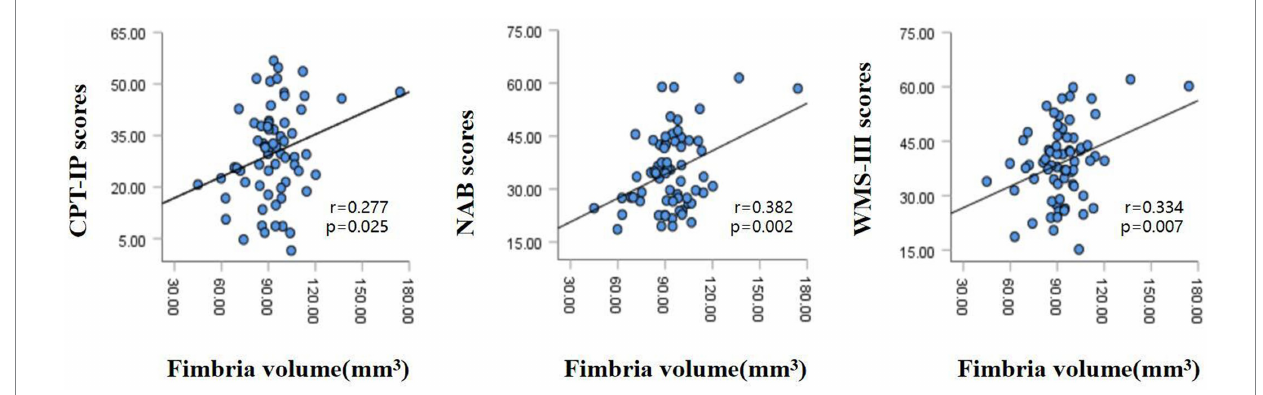
FIGURE 2 Relationships between hippocampal fimbria volume and CPT-IP scores, WMS-III scores and NAB scores in patients with schizophrenia, controlling for age and sex. CPT-IP, Continuous Performance Test-Identical Pairs; WMS-III, Wechsler Memory Scale, 3rd edition; NAB, Neuropsychological Assessment Battery.